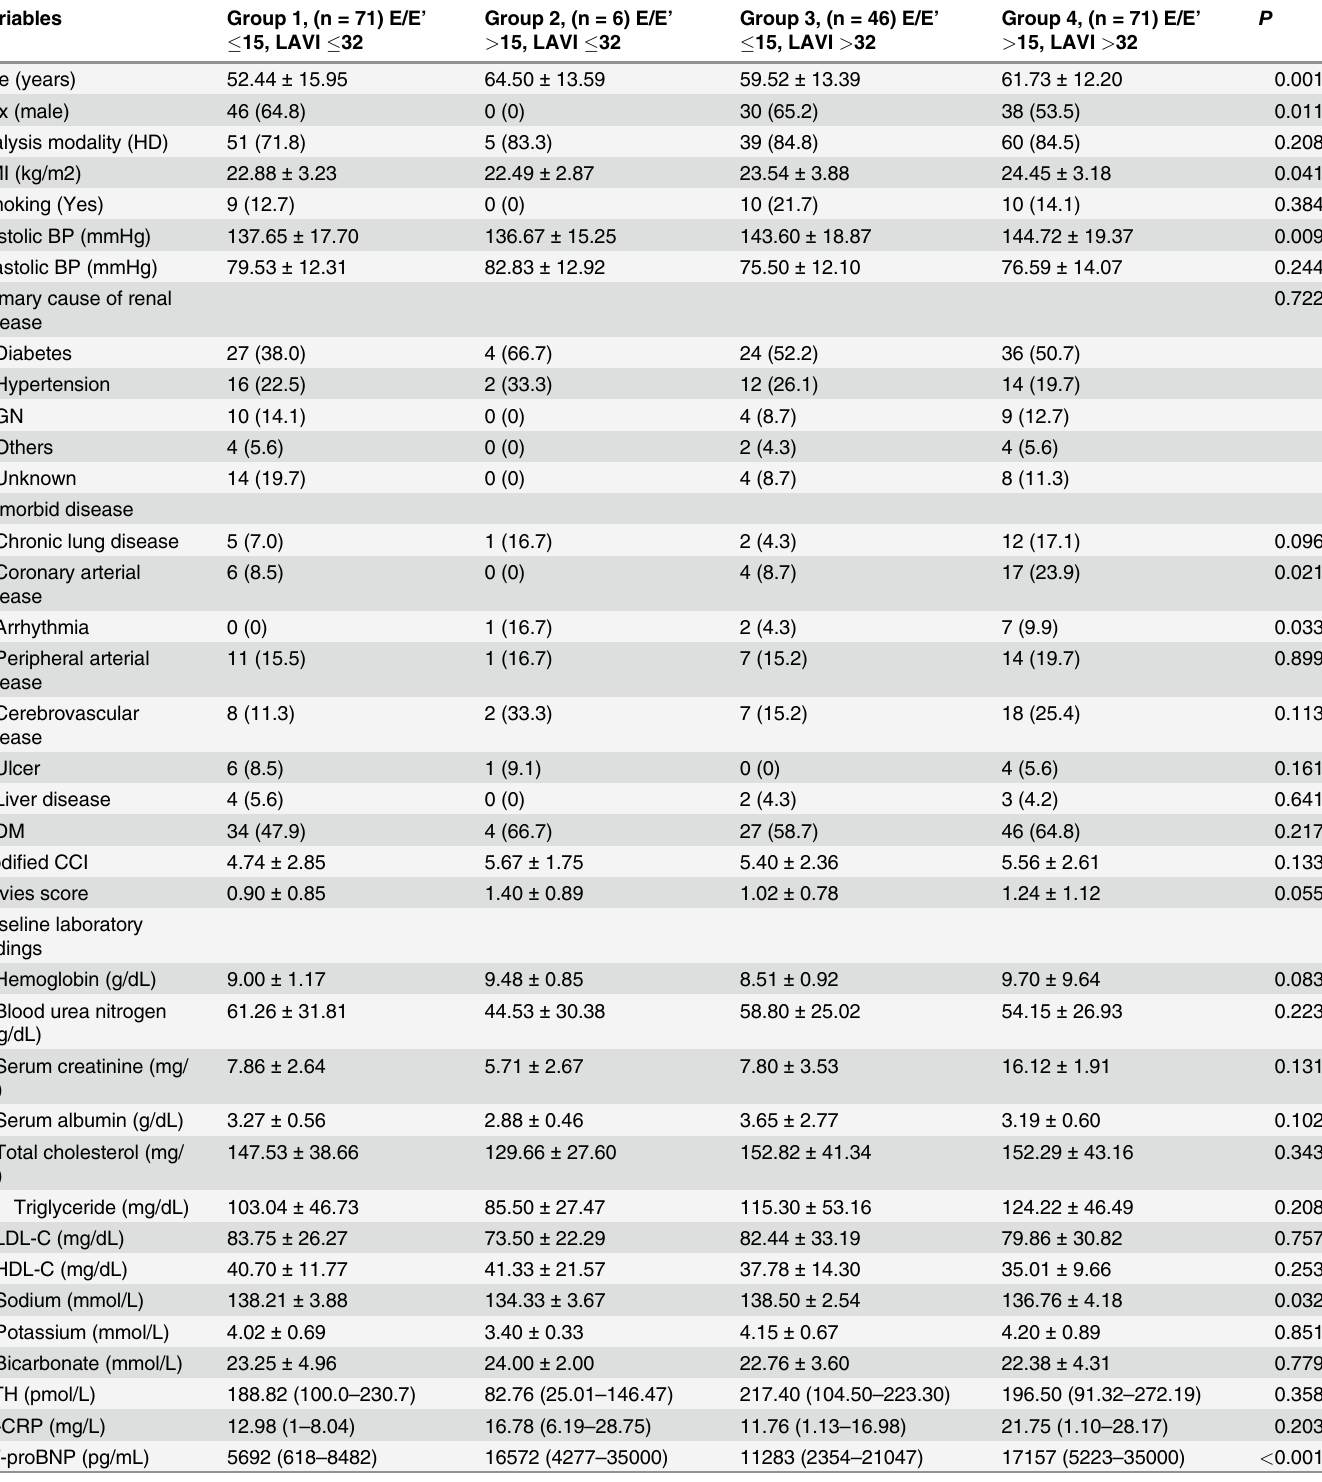
Table 5. Baseline characteristics and echocardiographic parameters of the study patients strati fi ed by E/E ’ and LAVI.